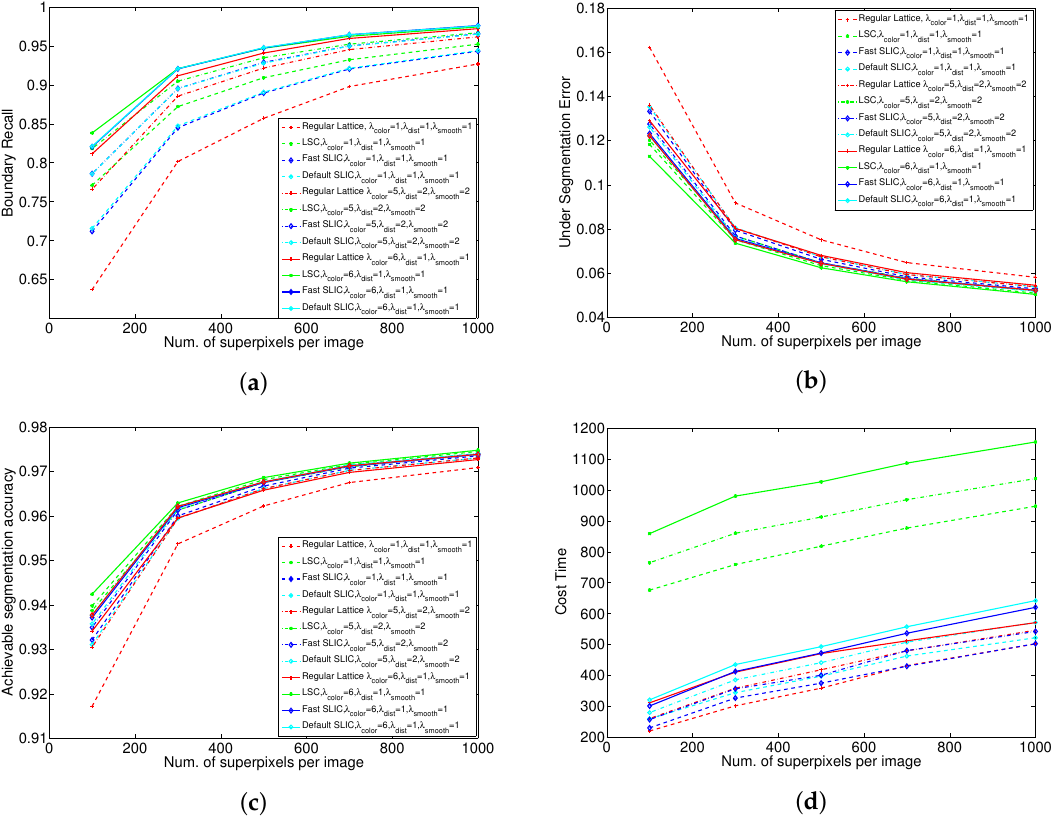
Figure 8. Performance and efficiency comparison of our method under different initial partitioning. ( a ) Boundary recall; ( b ) Under-segmentation error; ( c ) Achievable segmentation accuracy; ( d )